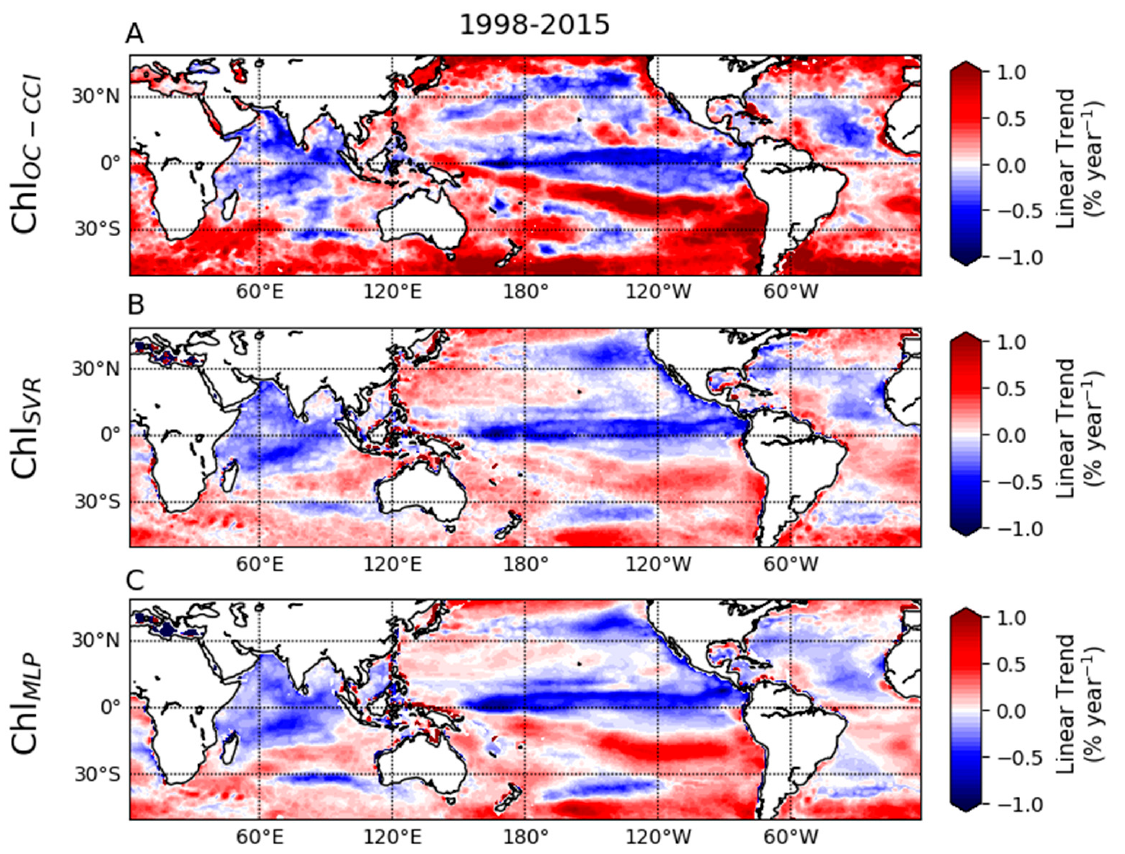
Figure 4. First mode of the Chl OC-CCI ( A ) seasonal and ( C ) interannual EOFs over 1998–2015, and their associated principal components ( B ) and ( D ), respectively. Chl MLP and Chl SVR PCs obtained from the Chl OC-CCI EOF projections are reported in ( B ) and ( D ).